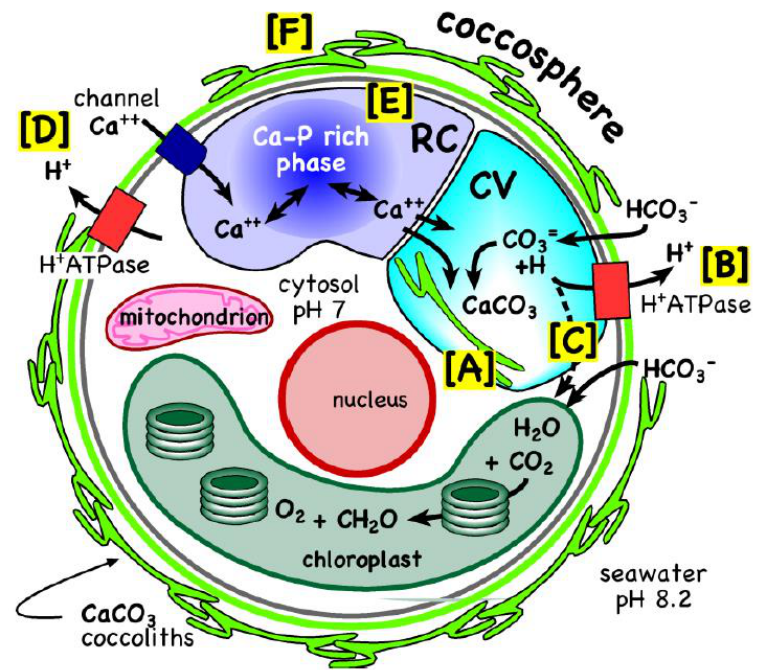
Figure 12. Calcification processes in coccolithophorids. [ A ] Coccolith formation occurs within the Golgi-derived coccolith vacuole (CV). [ B ] Intracellular CaCO 3 precipitation from bicarbonate (HCO 3 − ) releases equimolar H + that must be rapidly removed from the CV to maintain pH for CaCO 3 precipitation. [ C ] Some H + may be utilized by photosynthesis. [ D ] Though not fully understood, it is hypothesized that Ca 2+ is recruited through Ca-channels and V-type ATPase pumps. [ E ] A reservoir compartment (RC) concentrates Ca ++ and PO 4 3 − . [ F ] The coccolith-associated polysaccharide may drive the Ca 2+ from the coccosphere into the RC, from where only Ca 2+ is transported to the coccolith vesicle (CV) and PO 4 3 − is diverted to the cell for algal growth and reproduction. Transfer of Ca 2+ from the RC into the CV uses Ca 2+ channels and transporters. (This figure is an original interpretation by L. Pomar based on [88–91] and other